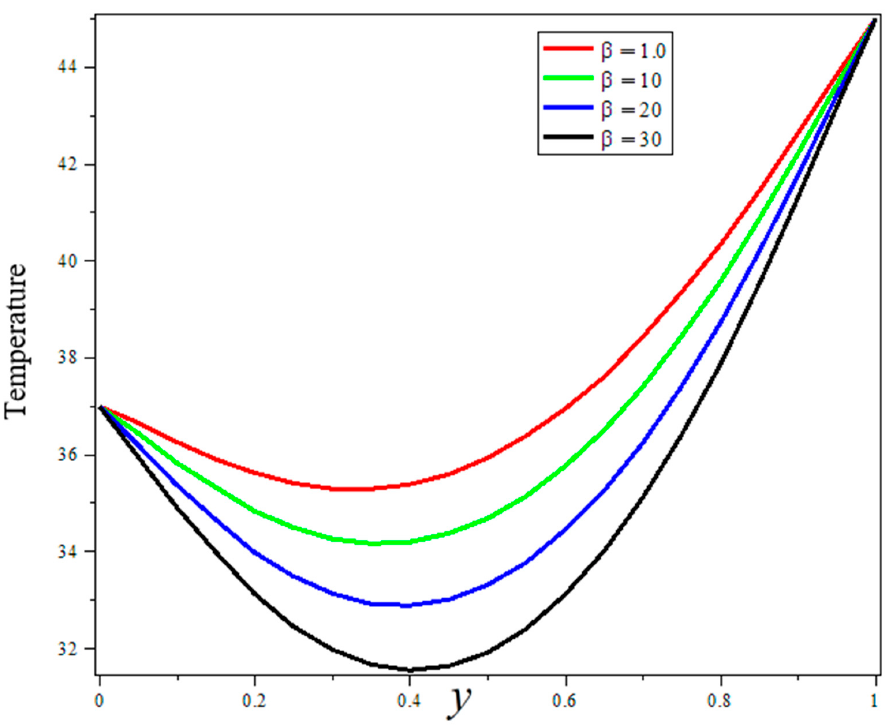
Figure 3. The impact of the source of heat on the temperature field throughout hyperthermia tumor treatment.